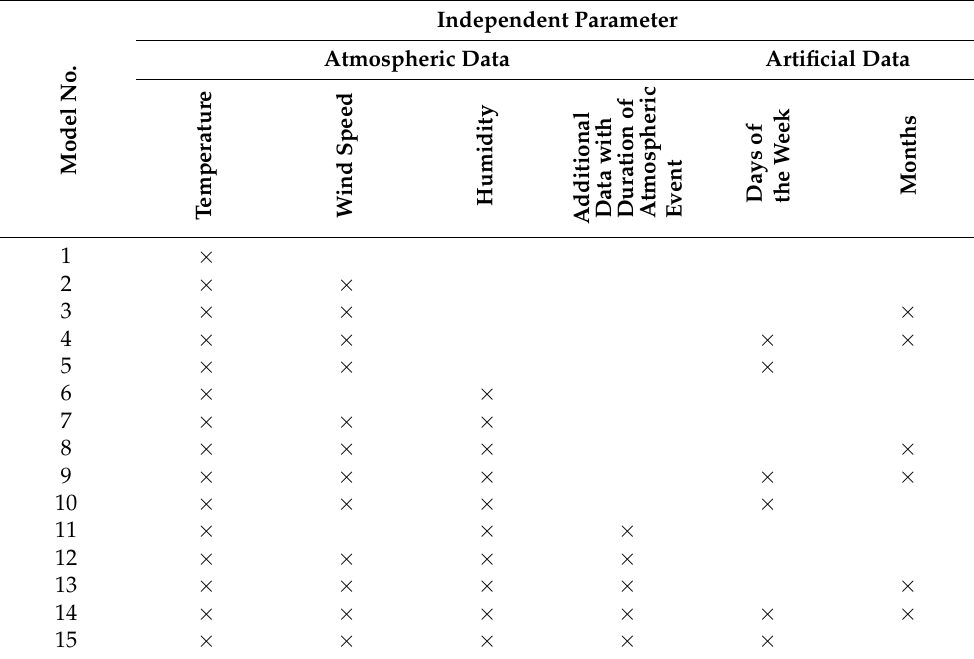
Table 1. Data ranges used to calculate the best model. Temperature: daily average, min/max, or at ground level.